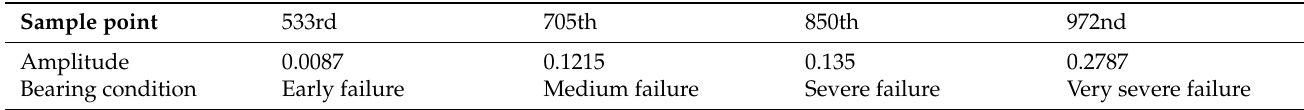
Table 2. Key sample point degradation